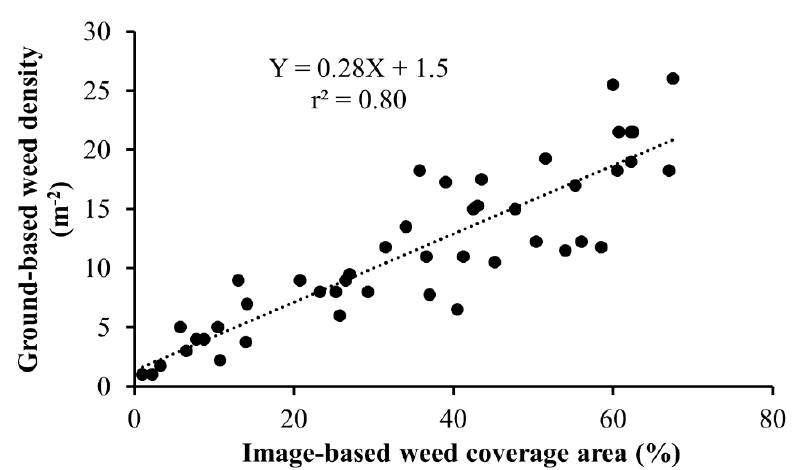
Figure 7. Linear regression showing the strength of association between weed pixel coverage (%) quantified using aerial imagery and overall weed density (no. of weeds m − 2 ) in the quadrats determined by ground truthing.